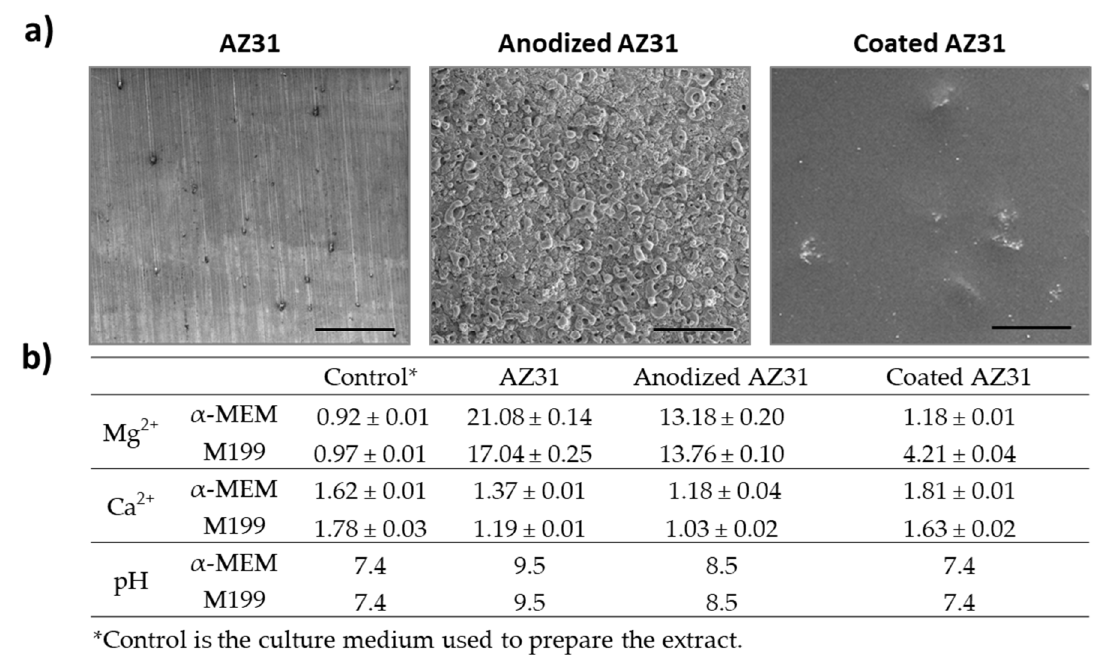
Figure 2. ( a ) Representative SEM images of the Mg-based substrates. Bar: 100 µm. ( b ) Concentration of Mg and Ca ions in the pure extracts (mM).